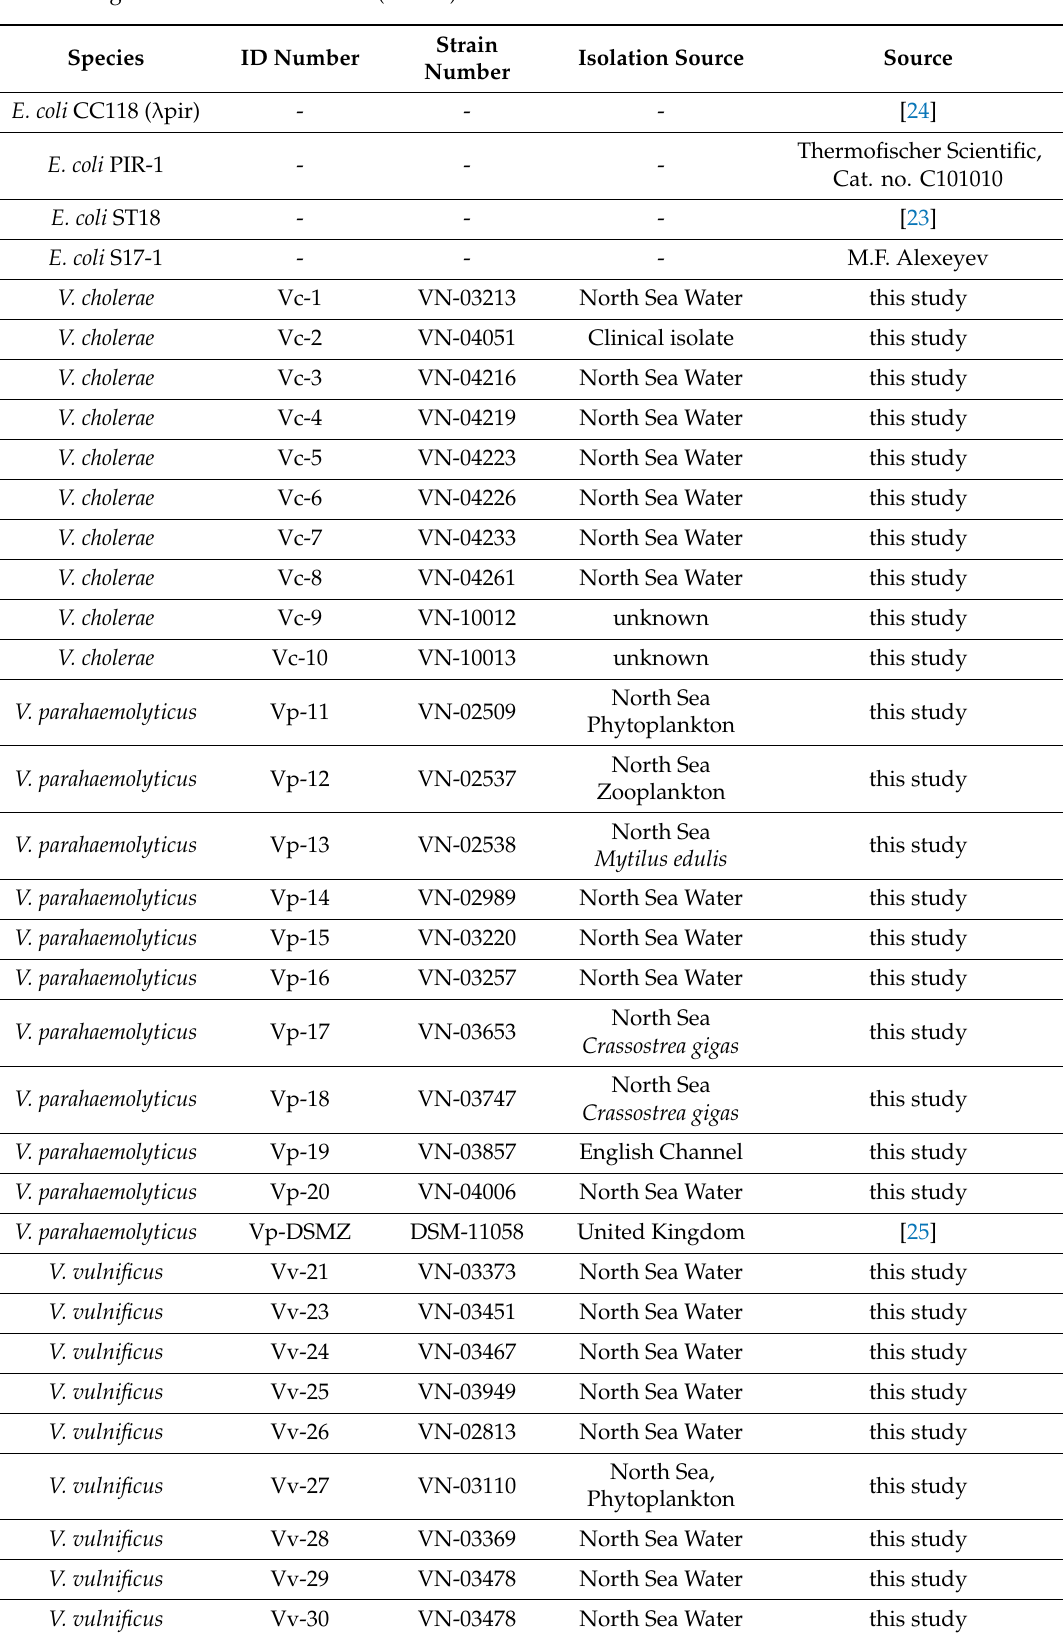
Table 1. Bacterial Strains and Species. ID Number corresponds to the numbering used throughout this study, the strain number refers to the strain’s entry in the VibrioNet database (VibrioNet Europe) at the Biological Institute Helgoland or the identification number from the German Collection of Microorganisms and Cell Cultures